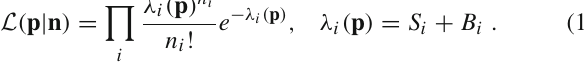
upperlimitsaregivenat90%C.L.,andtheuncertaintiesofthemeasured activities at 68%